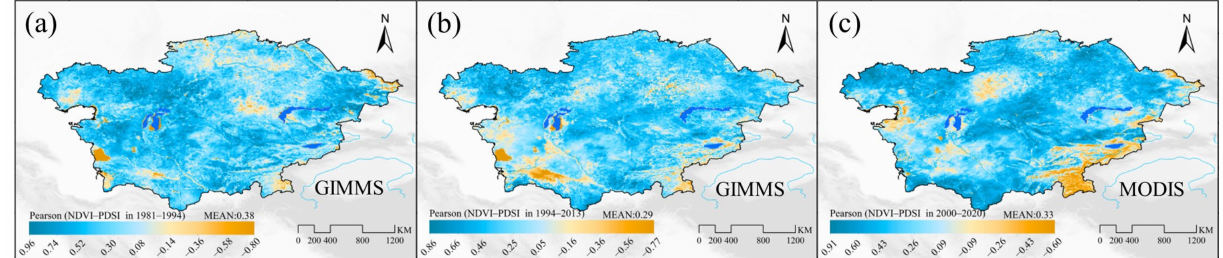
Figure 10. Correlation between NDVI and PDSI in Central Asia: ( a , b ) correlations between GIMMS NDVI (1981–2013) and PDSI before and after 1994, respectively; ( c ) correlation between MODIS NDVI and PDSI from 2000 to 2020.